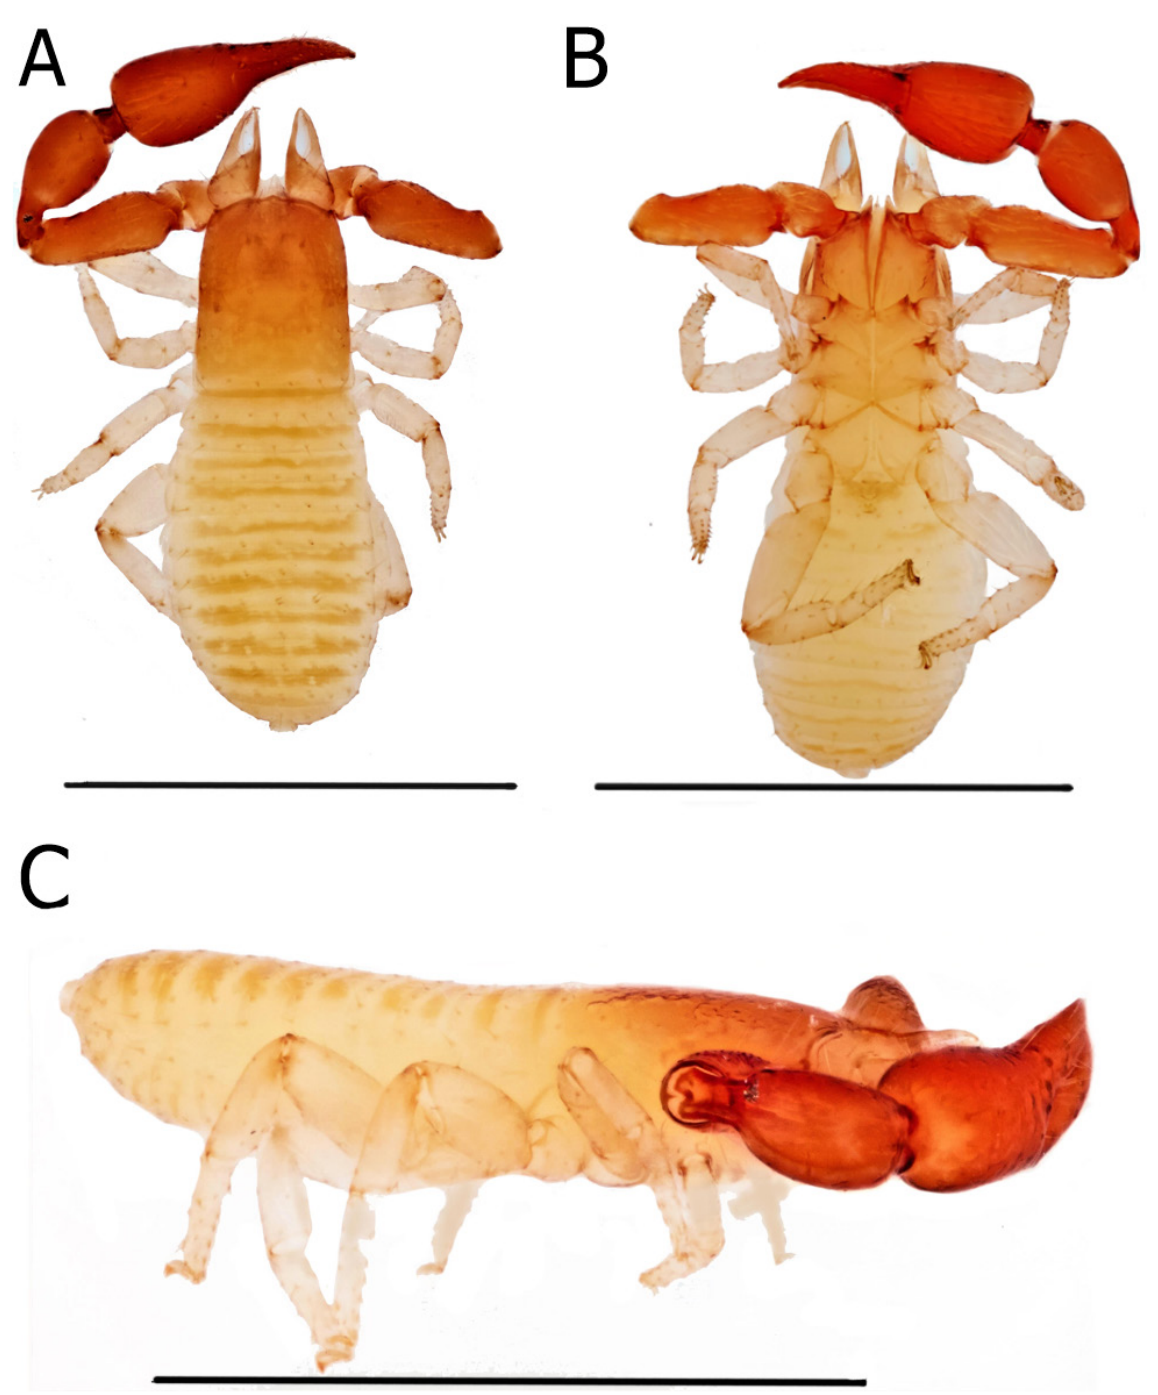
Fig. 19. Ideoblothrus nadineae sp. nov., holotype, ♂ (QCAZ). A . Habitus in dorsal view. B . Habitus in ventral view. C . Habitus in lateral view. Scale bars = 1